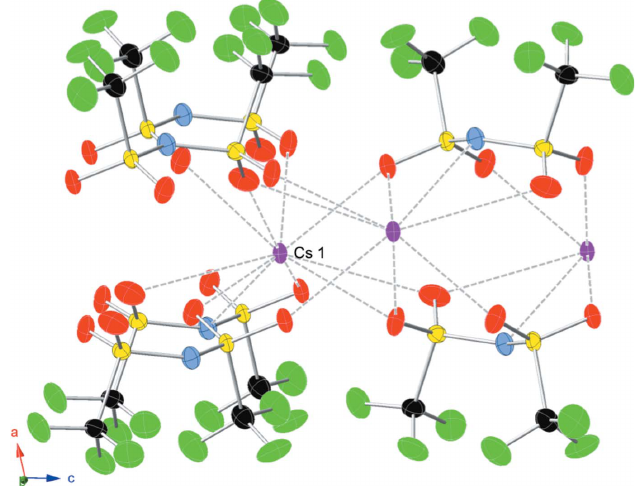
Figure 1 The coordination of the Cs + cation by nine oxygen atoms and one nitrogen atom of six different bistriflimide anions coordinating above and three below, in a view slightly off the (100) plane. Other caesium cations are crystallographically equivalent to Cs1, and are shown to depict how the sheet extends. The displacement ellipsoids are drawn at the 50% probability function with the color scheme of caesium (purple), oxygen (red), sulfur (yellow), nitrogen (blue), carbon (black), and fluorine